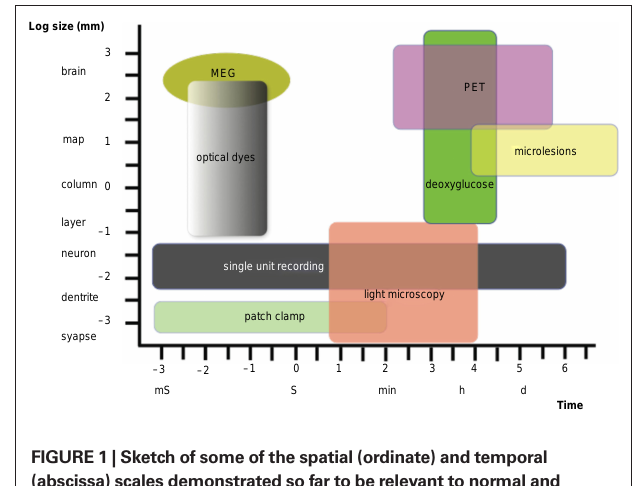
Figure 1 | Sketch of some of the spatial (ordinate) and temporal (abscissa) scales demonstrated so far to be relevant to normal and altered cognition, and the role of selected experimental methods to address inevitably limited aspects of these levels of organization and function. Note the considerable extent of the gaps in the manifold that are not covered by the technology represented, which are considerable larger if we take into account the subatomic (no less than 10 − 10 m and 10 − 44 s) and the evolutionary (astronomical distances and millions of years) scales. MEG, magnetoencephalography; PET, positron emission tomography. Modified from Churchland and Sejnowski